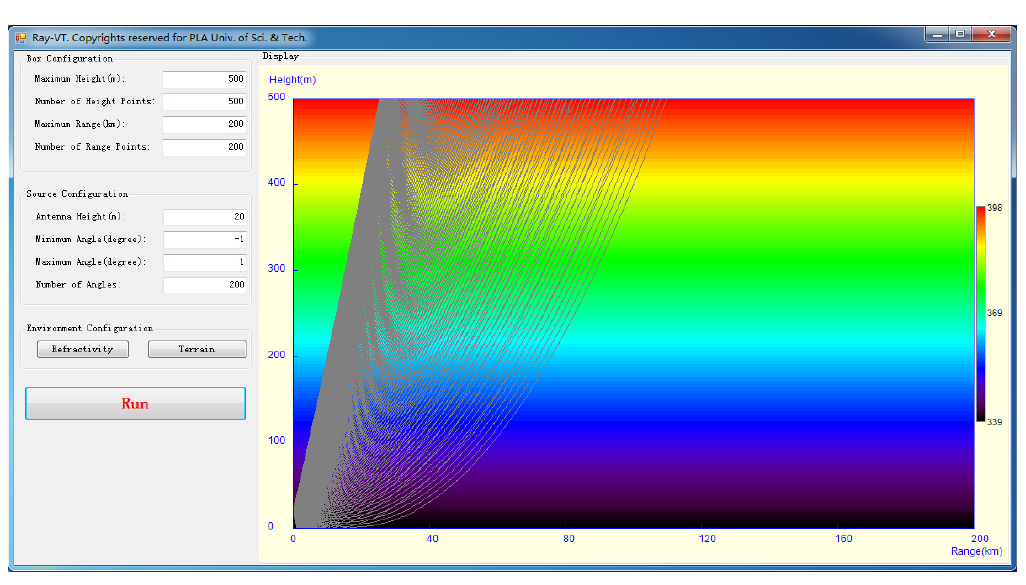
Figure 2. GUI (graphical user interface) of the Ray-VT for rays propagating through a standard refractive environment on a flat terrain.